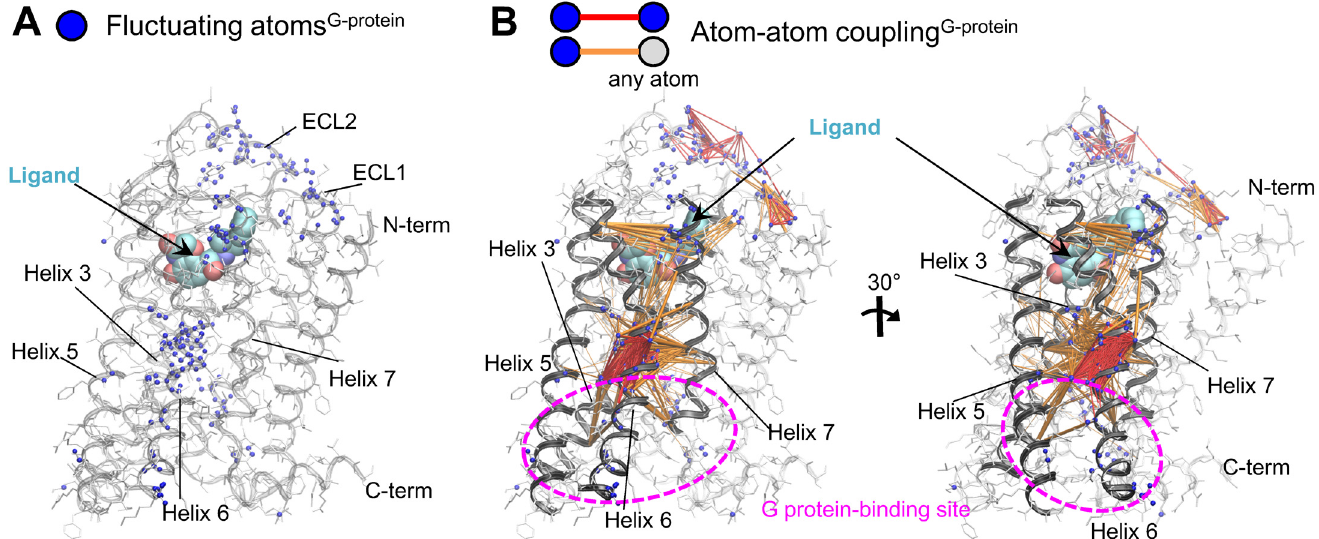
Fig 3. G-protein-linked fluctuating network of β 2 AR. (A) Fluctuating atoms G-protein , which have a Pearson ’ s correlation coefficient of more than 0.6 between their Δ RMSF and G protein efficacy, are indicated by blue spheres. (B) Atom – atom couplings G-protein were extracted from any pairs containing at least one fluctuating atom G-protein by correlation analysis between Δ PCC and G protein efficacy. The atom – atom pairs with more than a 0.6 Pearson ’ s correlation coefficient and within 12 Å are connected by lines. In the cases where both atoms are fluctuating atoms G-protein , the lines are colored red. In cases where one of the two atoms is a fluctuating atom G-protein , the lines are colored orange (see the Methods section). The G-protein-binding site is shown with a dashed magenta ellipse.